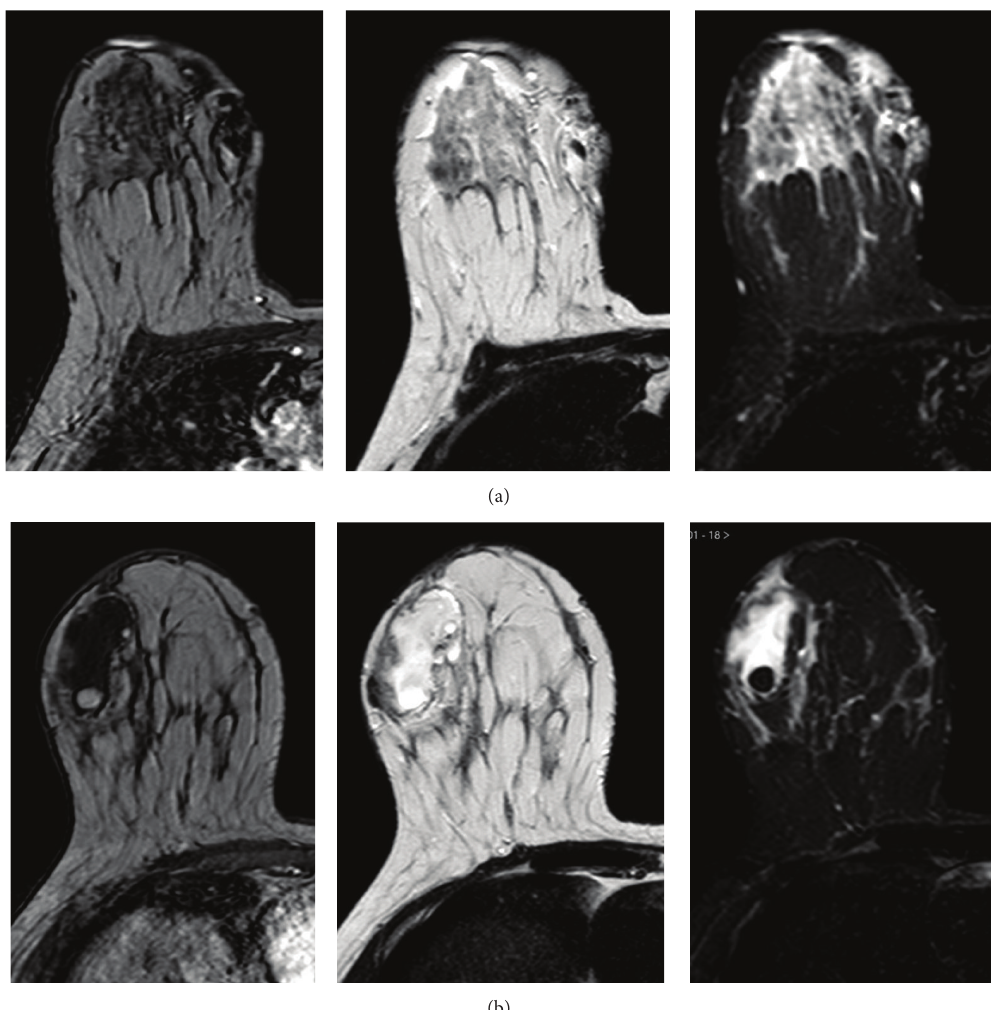
Figure 5: T1-weighted high resolution isotropic volume examination (THRIVE), T2-weighted sequences, and T2-weighted short tau inversion-recovery (STIR) sequences show a structural subcutaneous and cutaneous alteration with pseudonodular appearance in the upper inner quadrant of the right breast (a) and a T1 mixed hyper- and hypointense and T2 hyperintense lesion in the lower outer quadrant of the right breast, suggested for an inflammatory fluid pocket